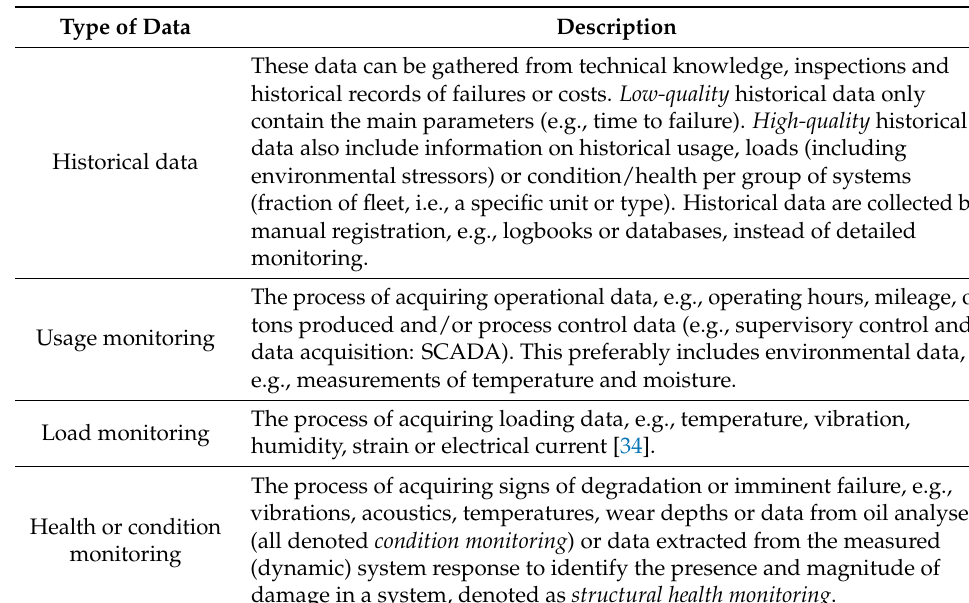
Table 2. Description of data